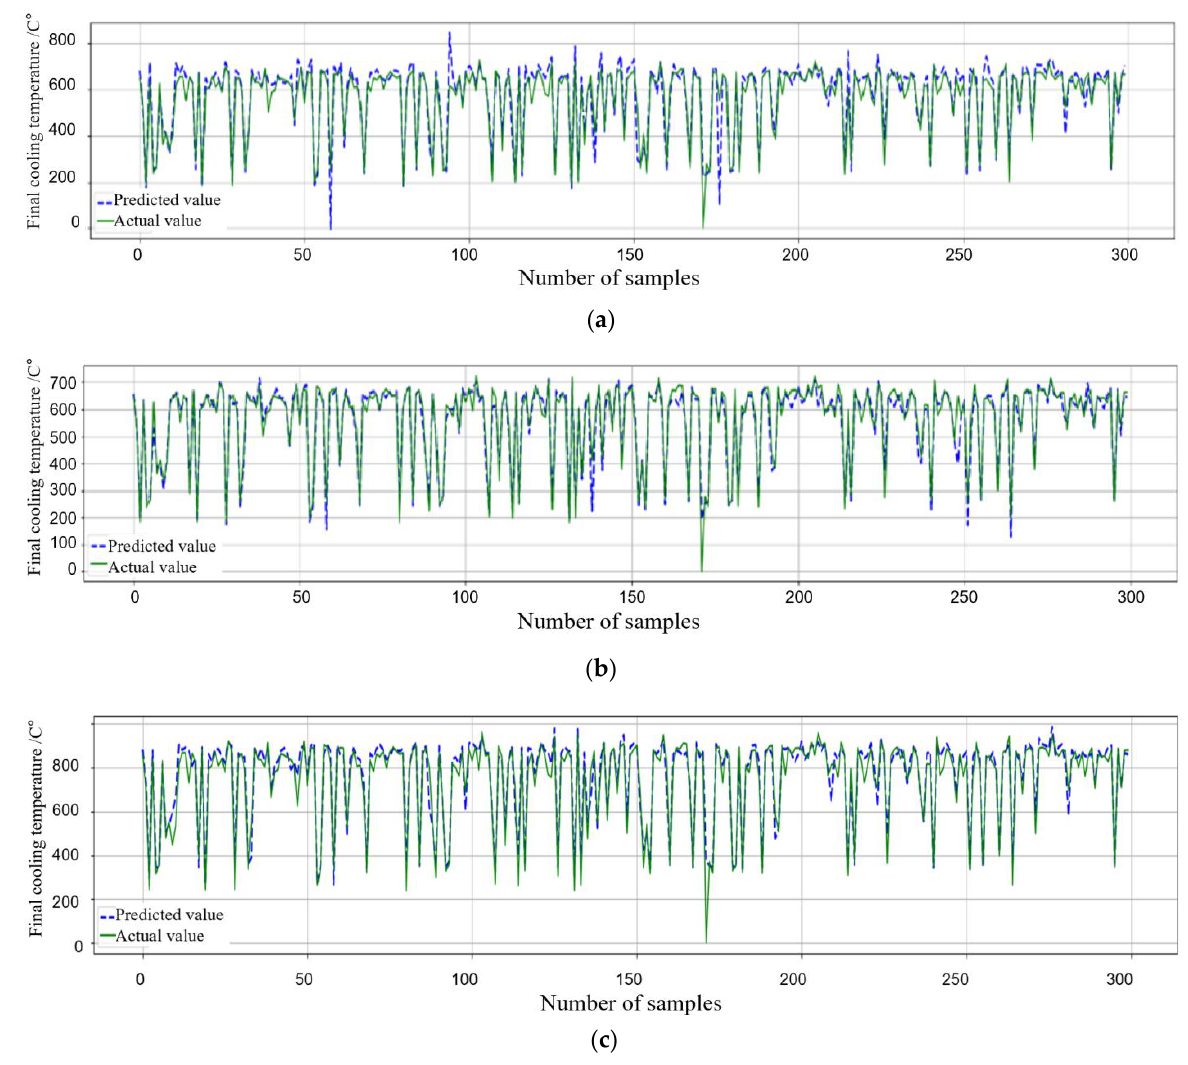
Figure 9. ( a ) Fitting curves of the predicted value and actual value of BP neural network in the test set; ( b ) fitting curves of the predicted value and actual value of convolutional neural network in the test set; ( c ) fitting curves of the predicted value and actual value of the multi-scale convolutional neural network in the test set.